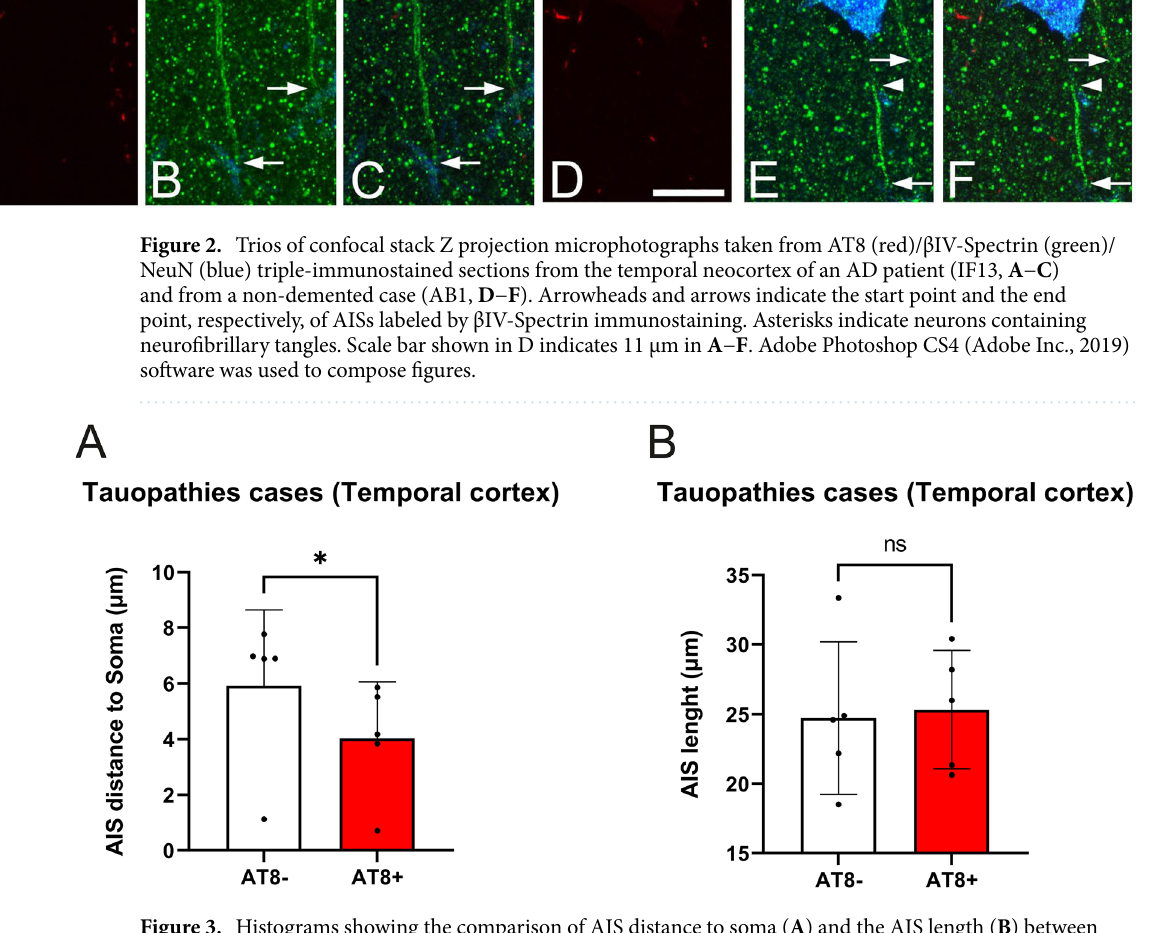
Figure 3. Histograms showing the comparison of AIS distance to soma ( A ) and the AIS length ( B ) between all the AT8- and AT8 + neurons analysed. Note the significant ( p = 0.02) decrease in AIS distance to soma in AT8 + neurons (SPSS software). Adobe Photoshop CS4 software was used to compose figures. Imaris software was used to measure—in 3D—the AIS length and/or